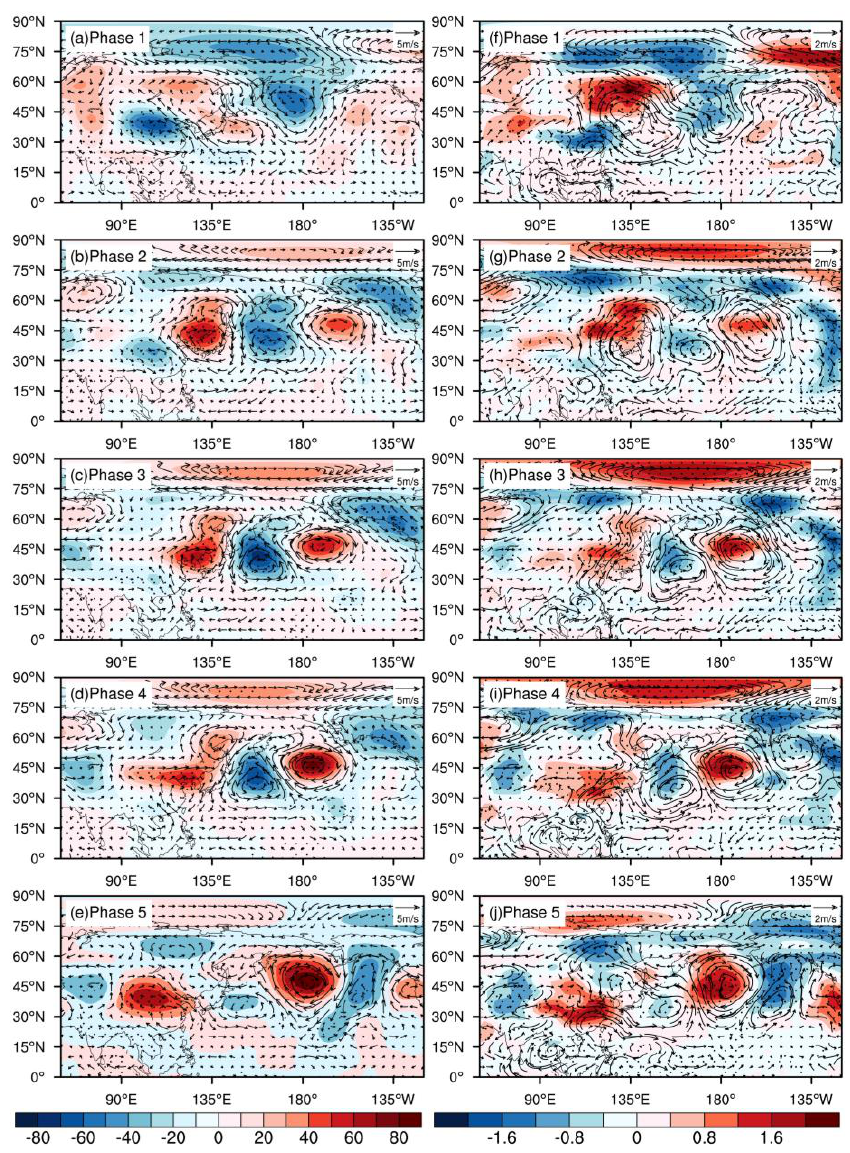
Figure 8. ( a – j ) Same as Figure 5, expect for the second type of